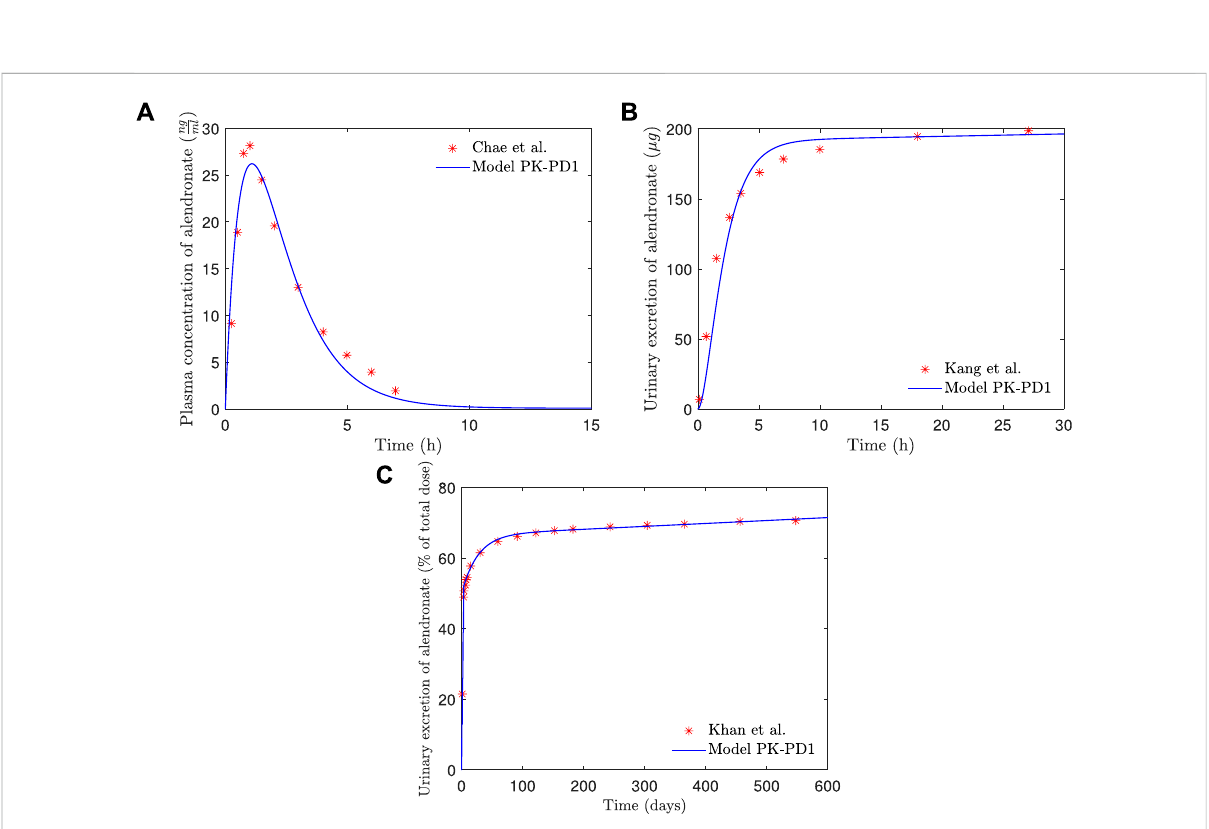
FIGURE 7 PK-PD1 modelresultsofalendronate: (A) plasmaconcentrationversustime; (B) short-termurinaryexcretionvs.time;and (C) long-termurinary excretion vs.